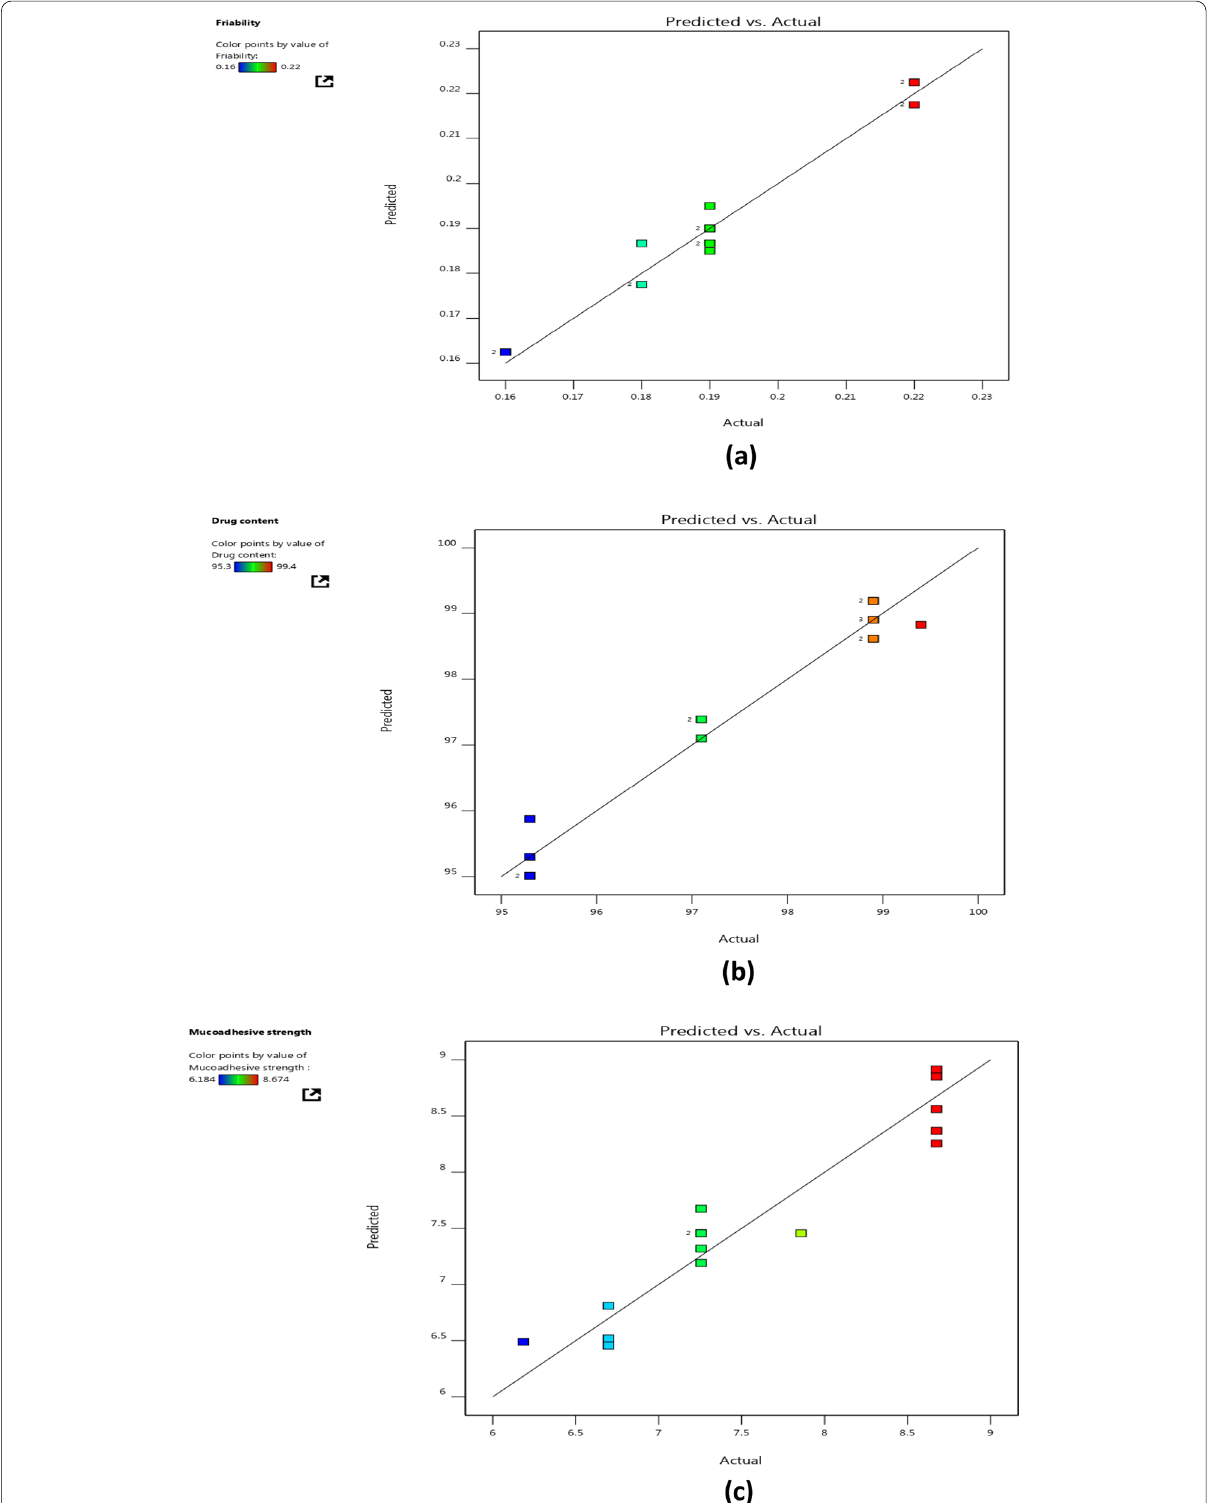
Fig. 2 Predicted versus actual value for the observed responses of R 1, R 2 and R 3 ( a – c